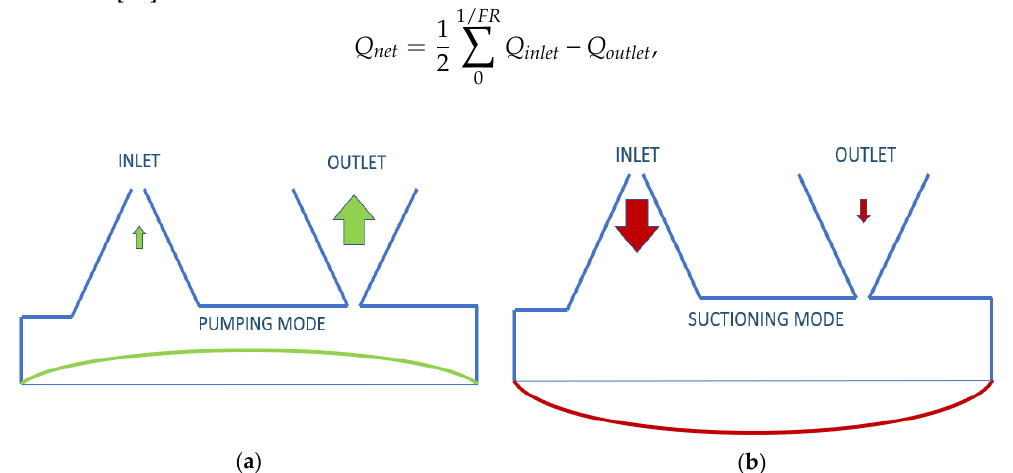
Figure 1. Working principle of valveless piezoelectric pump illustration: ( a ) pumping mode; ( b ) suctioning mode.